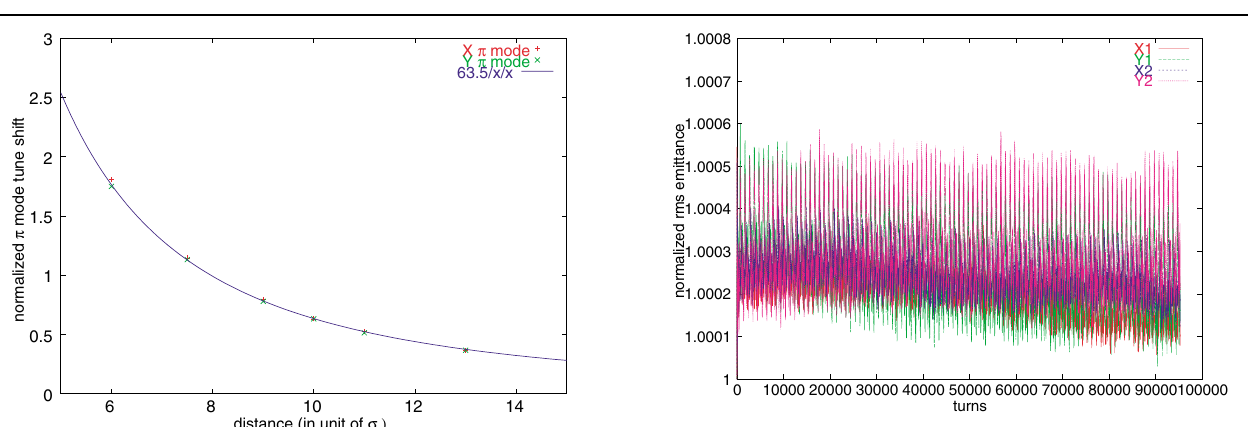
FIG. 6. (Color) Normalized (cid:13) mode tune shift as a function of horizontal separation for the case of long-range beam-beam collisions.